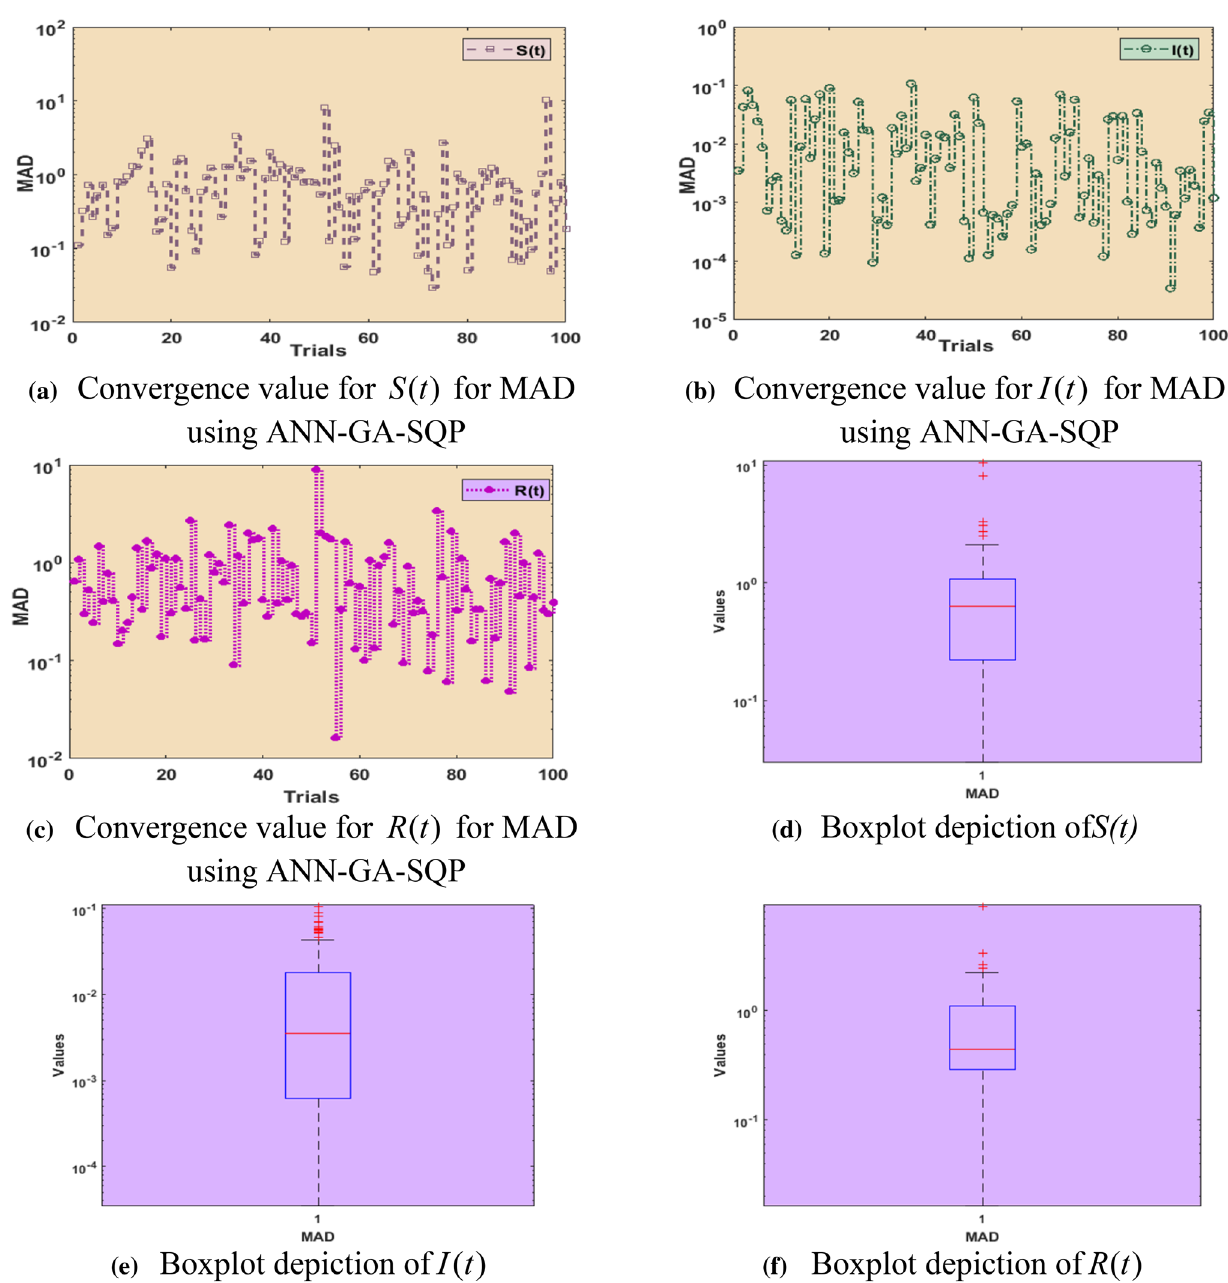
Fig. 5 Performance analysis of MAD for S ( t ), I ( t ) , R ( t ) with boxplots including 5 neurons using ANN-GA-SQP for COVID-19 SIR Fig. 6d–f the box plots of all five parameters for RMSE are displayed. of Boxplots for S ( t ) , I ( t ) and R ( t ) are between 10 –1 to 10 0 , 10 –1 to 10 1 , 10 –4 to 10 −1 , respectively.